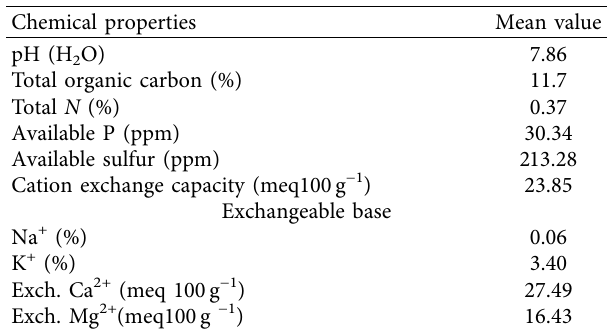
Table 2: Chemical properties and nutrient concentrations of utilized CHC